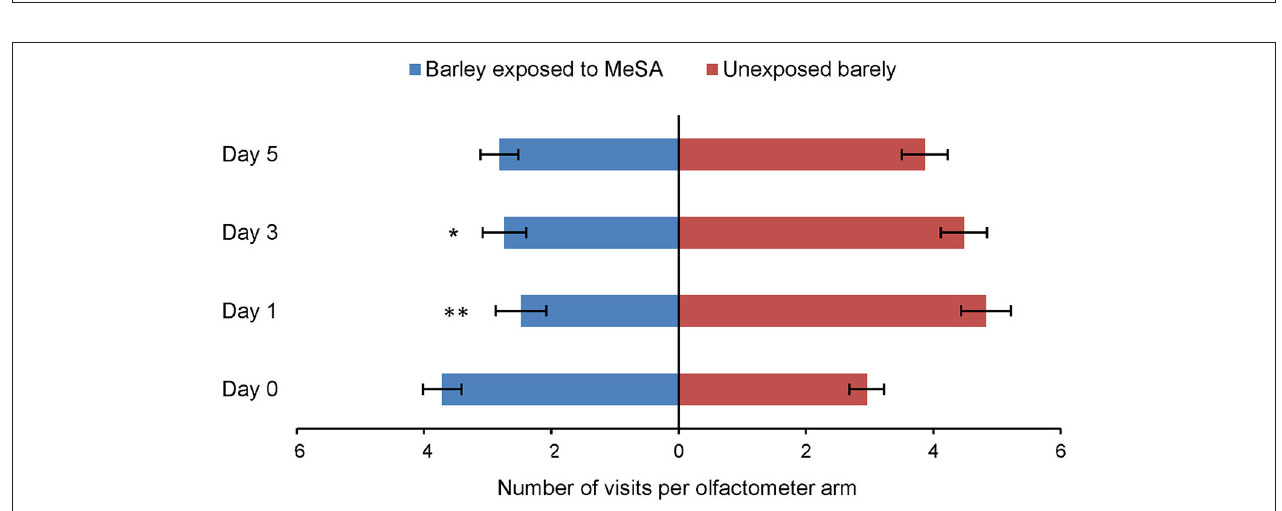
FIGURE 2 | Olfactory response of R. padi (mean visits in olfactometer arm ± SE) to odor of unexposed barley plants or to plants exposed to MeSA (directly after removal of MeSA exposure = Day 0 and at time points 1, 3 and 5 days after removal of MeSA exposure). * p ≤ 0.05; ** p ≤ 0.01 after Wilcoxon matched pairs tests.